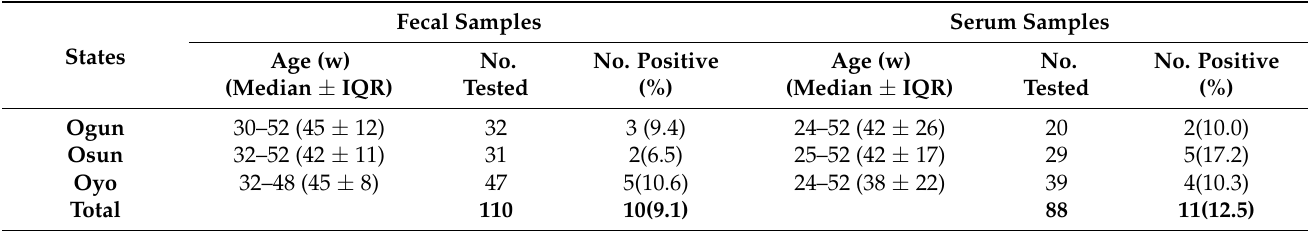
Table 2. Occurrence of aHEV in fecal and serum samples collected from three states in Nigeria. Fecal States